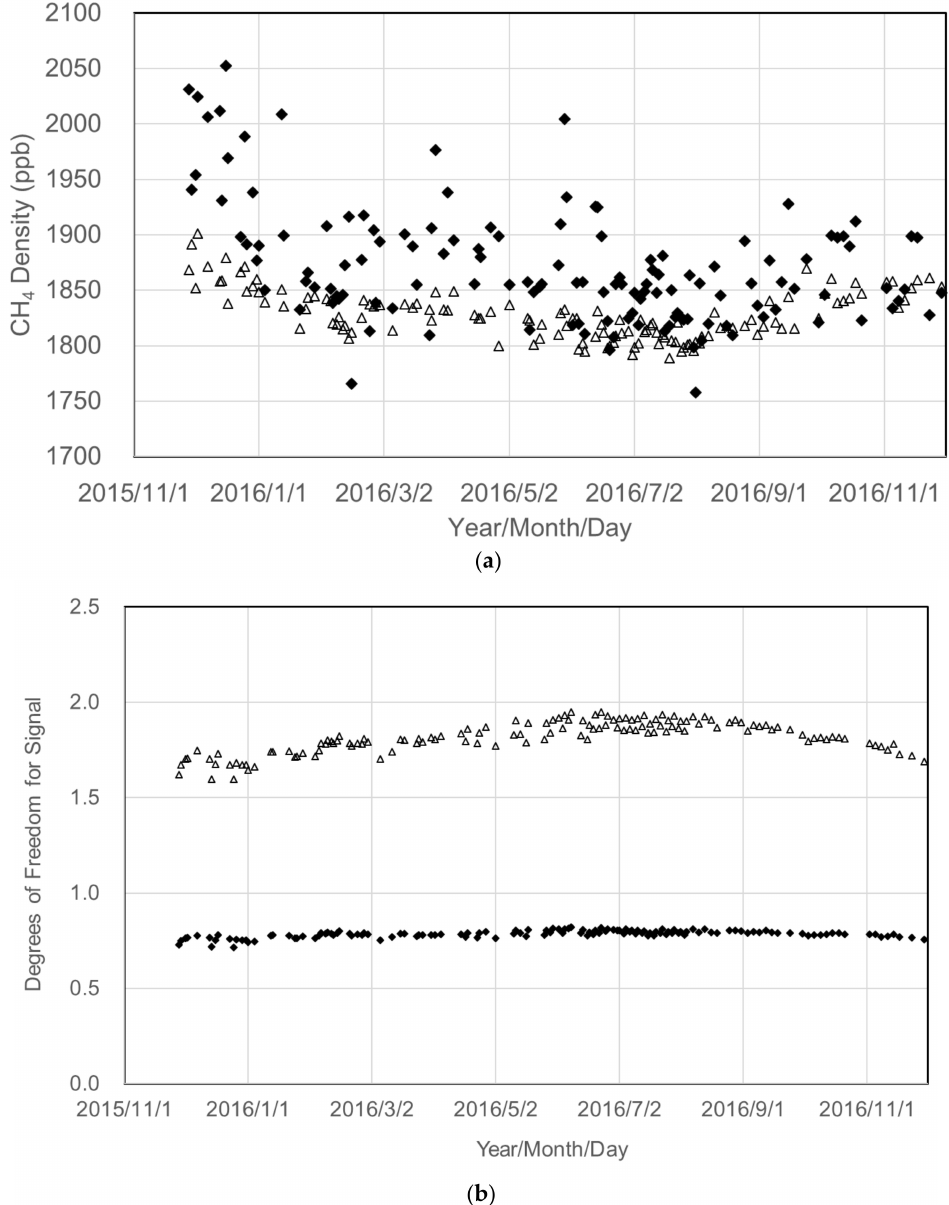
Figure 2. ( a ) CH 4 total partial column-averaged dry-air mole fractions (XCH 4 ) (triangles) and the lower troposphere (XCH 4 (LT)) (diamonds) at Aliso Canyon-S; and ( b ) the same as ( a ) except for the typical degrees of freedom for the signal (DFS) in